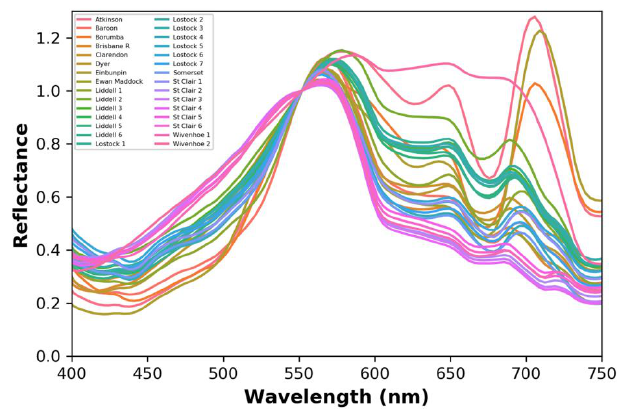
Figure 6. Satlantic Rrs spectra from the 13 water bodies measured, normalized to 550 nm.